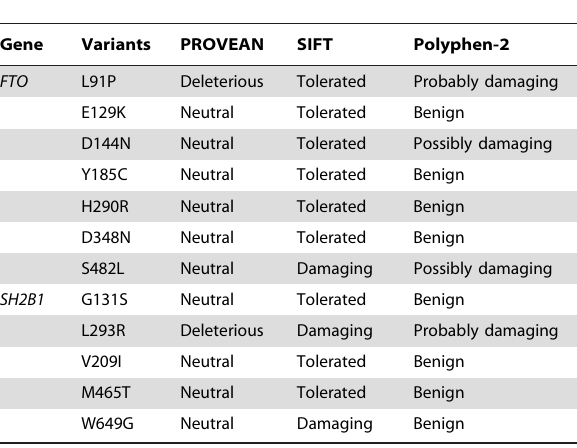
Table 6. Functional impacts of FTO and SH2B1 rare non- synonymous